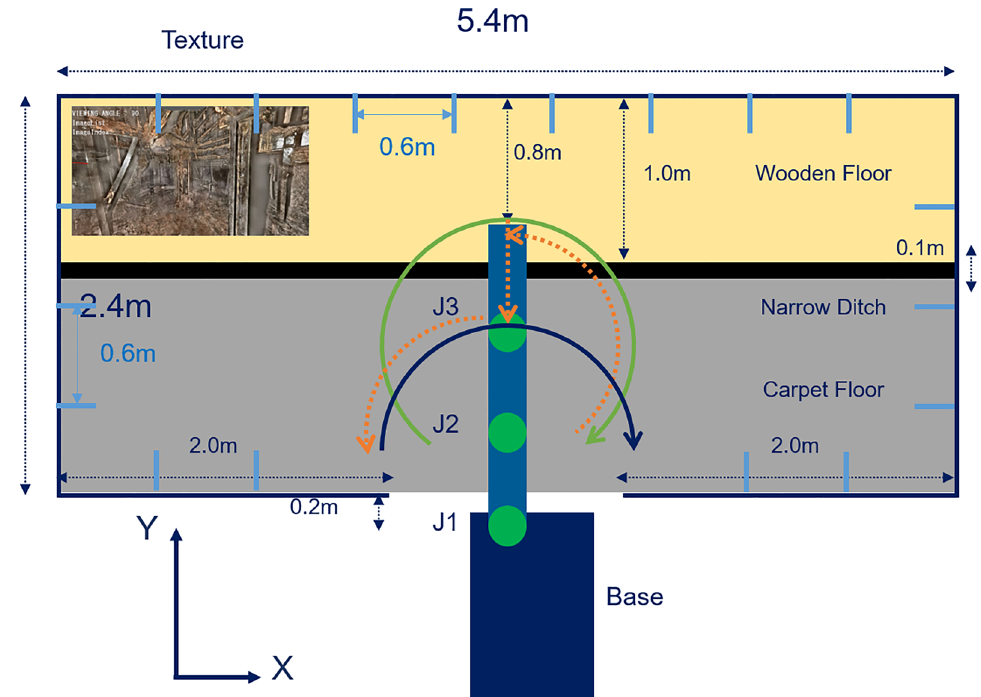
Fig. 18 Distribution of illumination measurement points